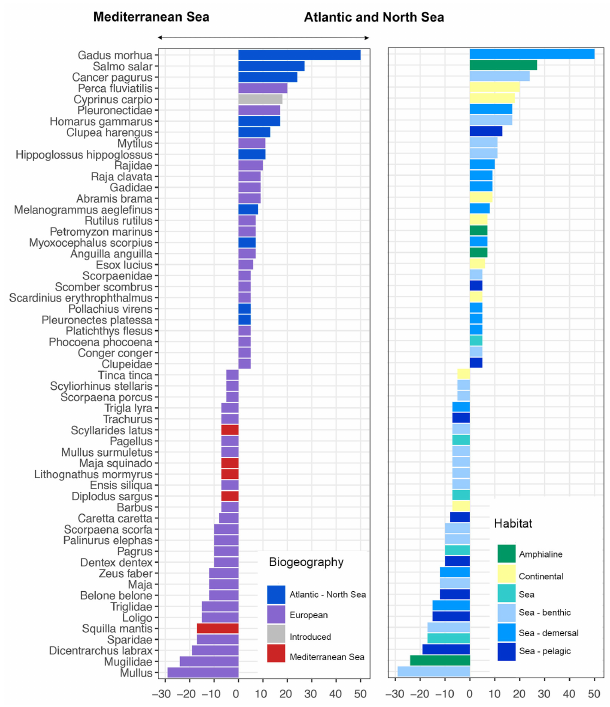
Fig. 3 . Representation in paintings of taxa by region. Differences between the proportions (in %) of paintings (located in the Mediterranean Sea and in the Atlantic-North Sea) where each selected taxon is represented. Left panel: taxa colored according to Biogeography. Right panel: taxa colored according to Habitat Group. Only the taxa with a difference of more than 5% between the Atlantic-North Sea and the Mediterranean Sea are shown.